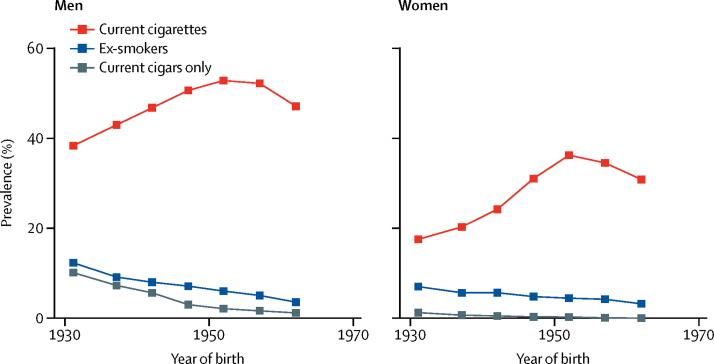
Smoking prevalence in the baseline survey (1996–2002) by year of birthProportion of participants at baseline who were current smokers of cigarettes, current smokers of cigars only, or ex-smokers (of either cigarettes or cigars). Years of birth are divided into the following categories: before 1935, 1935–39, 1940–44, 1945–49, 1950–54, 1955–59, and 1960 or after.